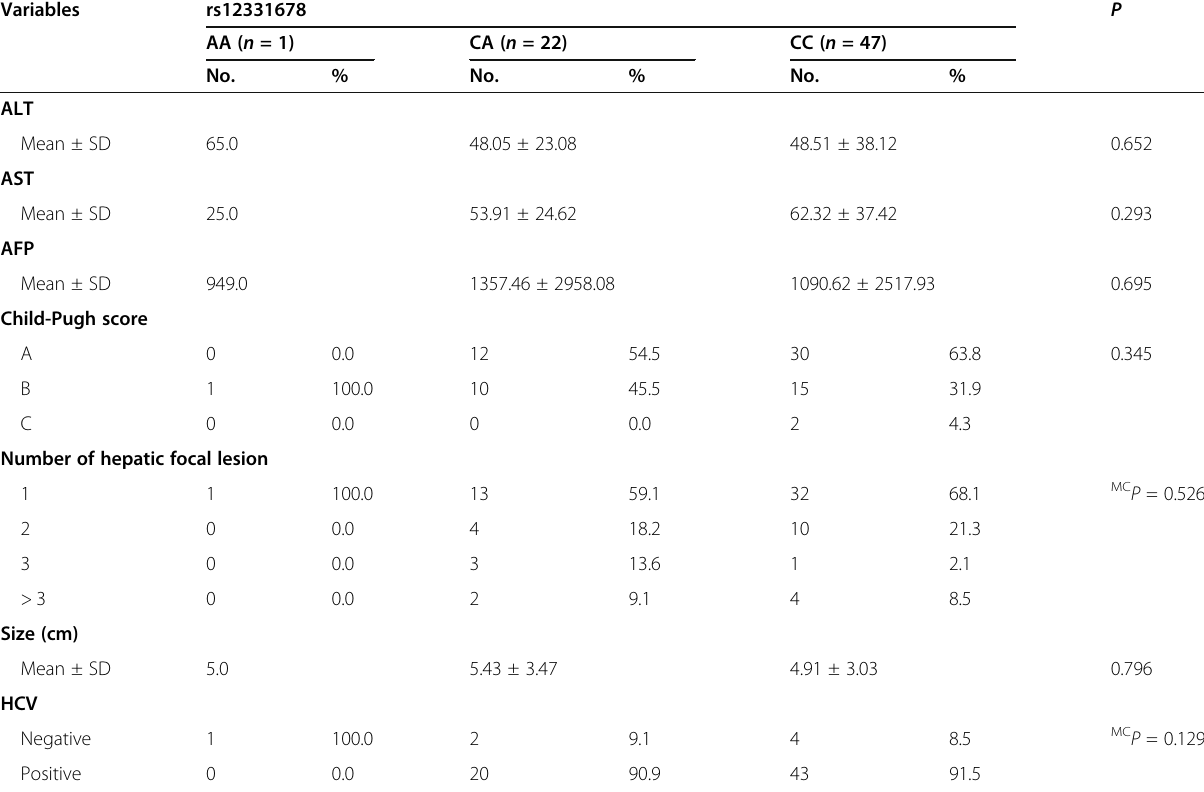
Table 4 Association between rs12331678 and clinicopathological features